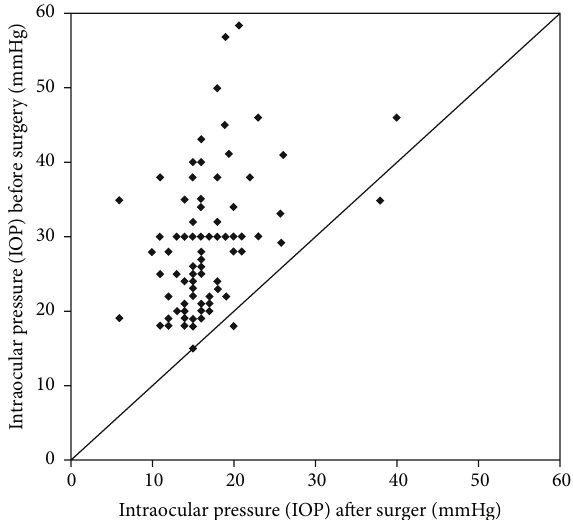
Figure 10: Scatter plot of IOP values before and after canaloplasty after 2 years (80 eyes).